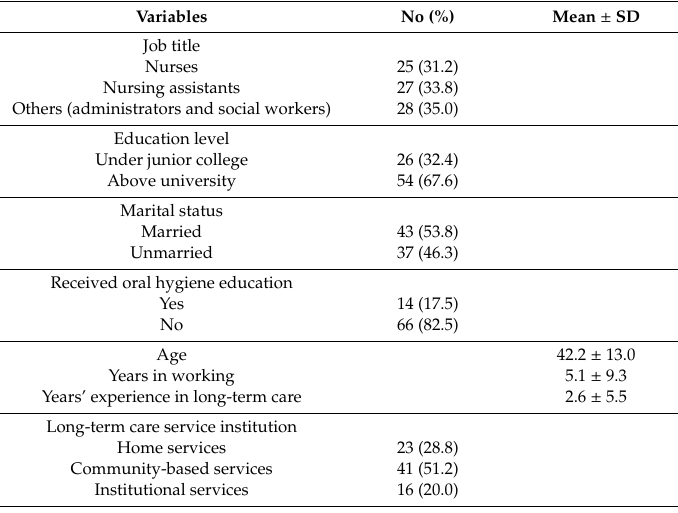
Table 2. Demographic information (N =